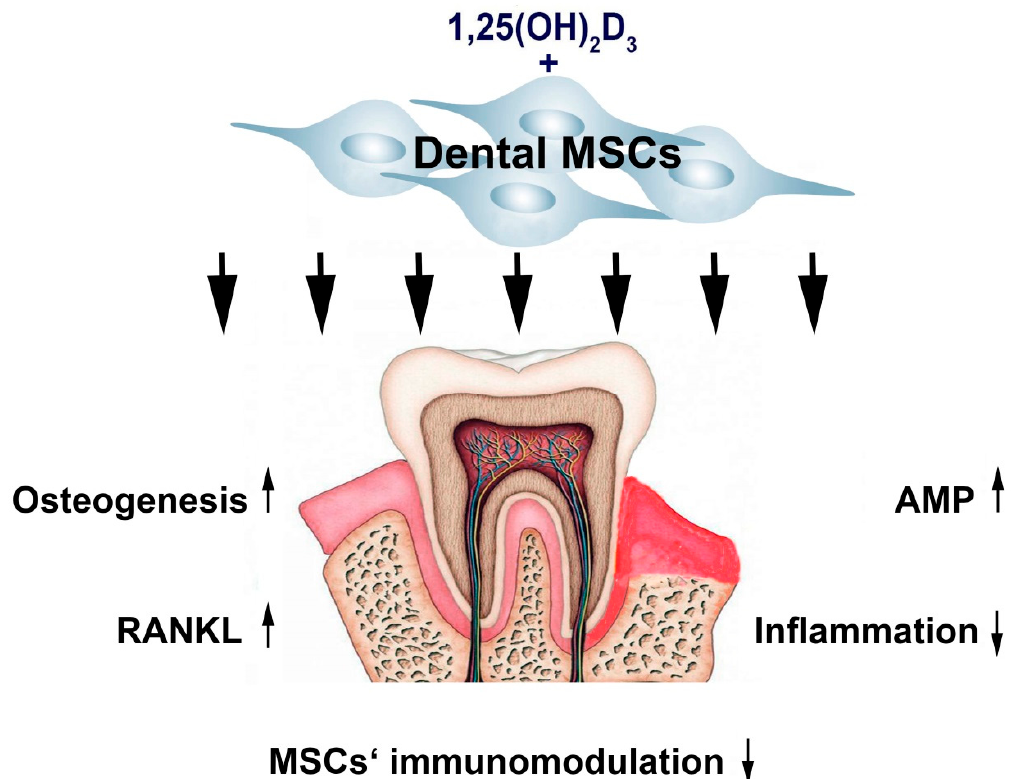
Figure 2. Effects of biologically active vitamin D 3 metabolite 1,25(OH) 2 D 3 in dental mesenchymal stromal cells.